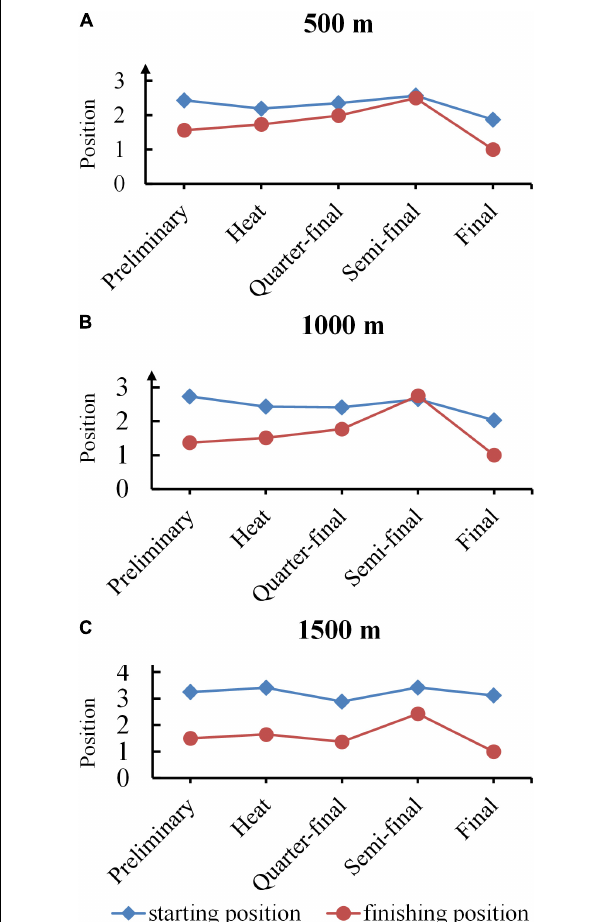
FIGURE 2 | Dynamical evolution of starting and finishing position for champions. (A–C) Profiles of starting and finishing position for 500, 1000, and 1500 m champions. The blue broken line with a square mark represented starting positions, while the red one with a circle represented finishing positions.